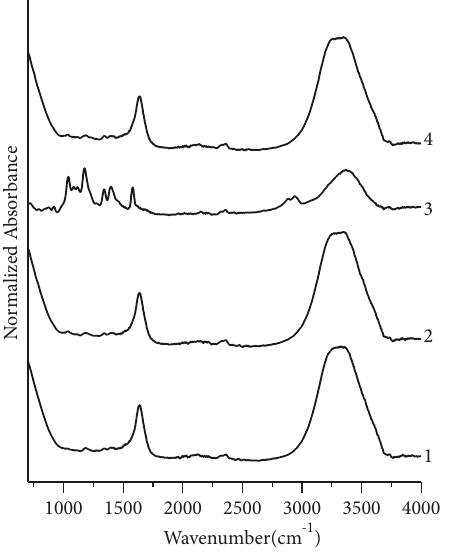
Figure 6: Normalized FTIR absorption spectra for blue fountain pen ink. 1, 2, 3, 4, 5, and 6 represent samples no. BL1, BL2, BL3, BL4, BL5, and BL6, respectively.